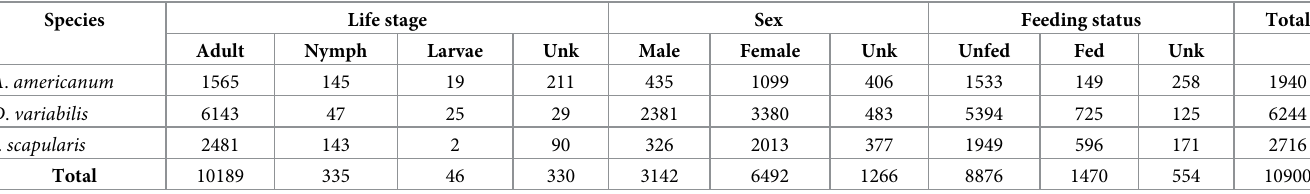
This data was used to train and evaluate TickIDNet. Images marked as discard during the image quality assessment are not included in this summary. Unk: Unknown.